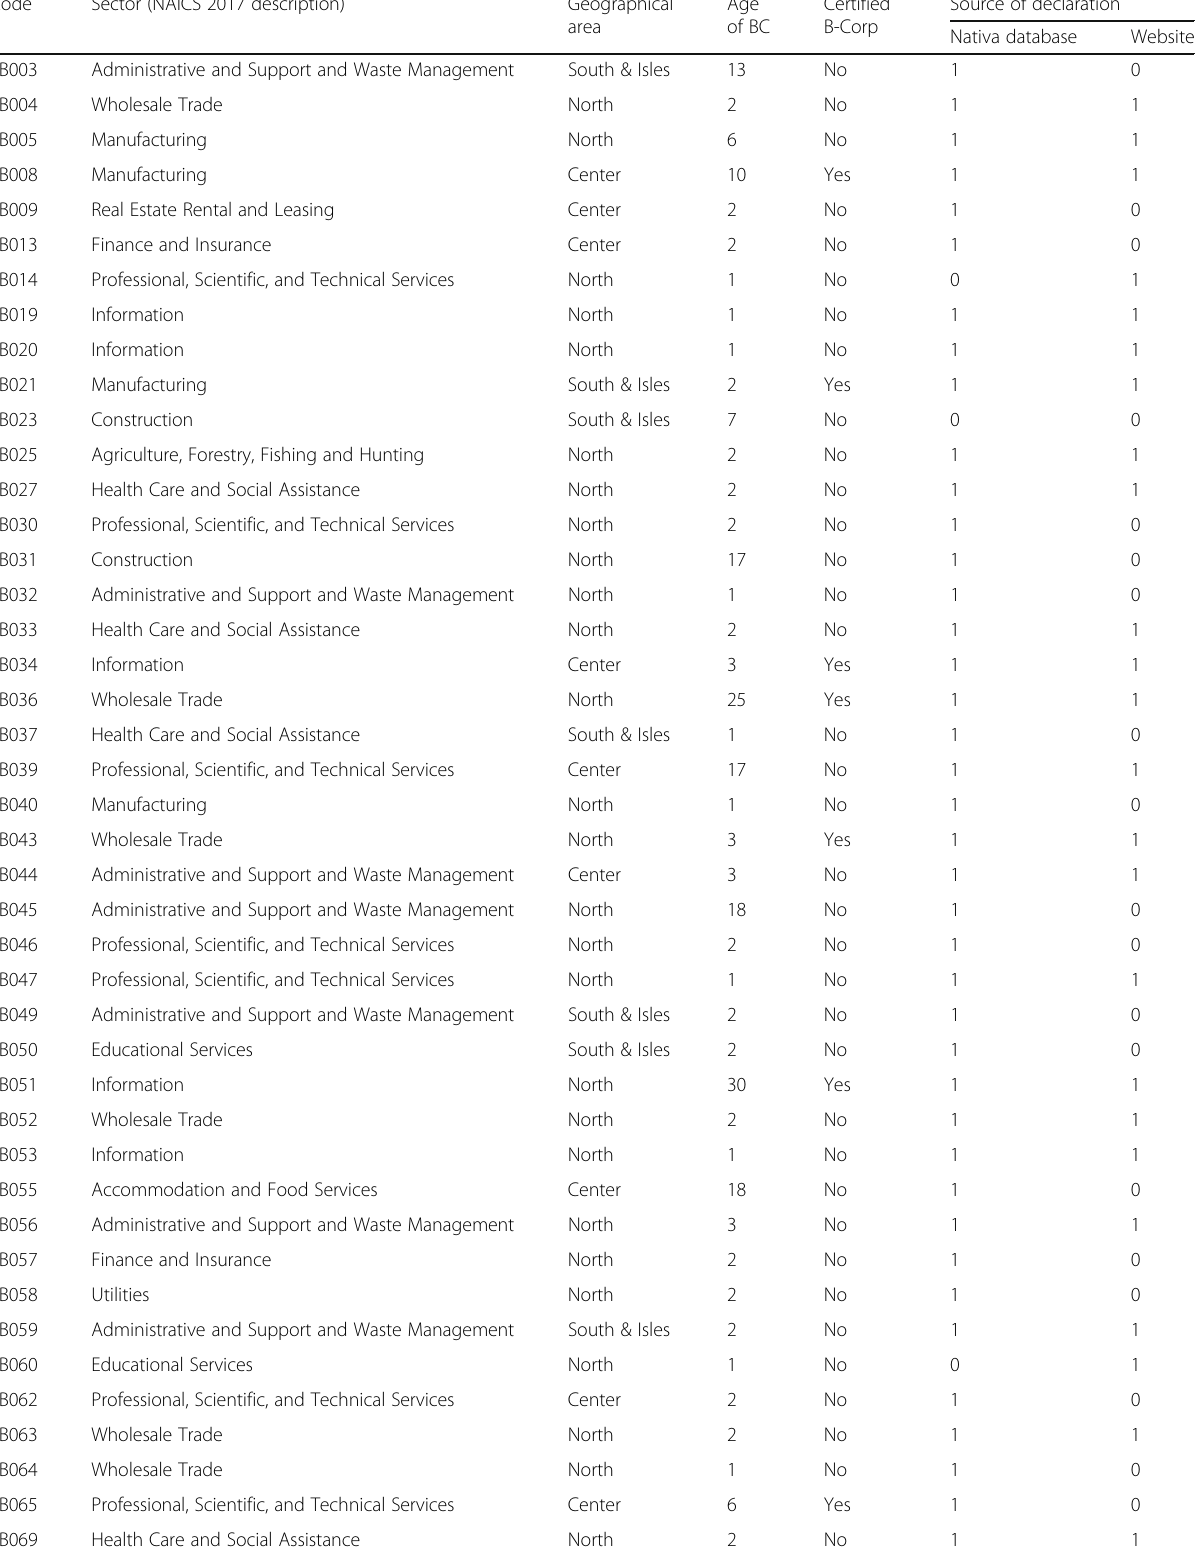
Table 1 Sample of analysis and main characteristics of BCs